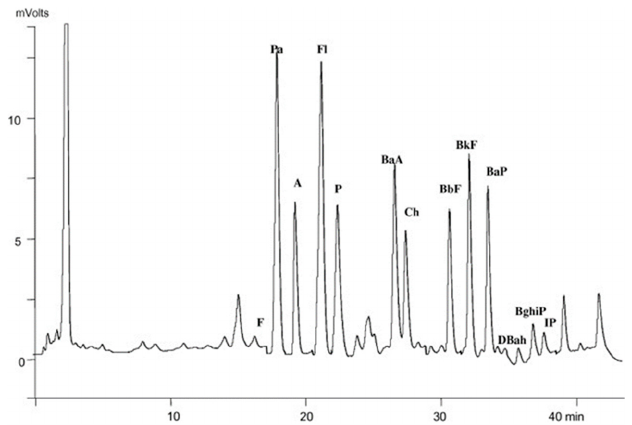
Figure 3. HPLC-FLD (high performance liquid chromatography-spectrofluorometric detection) trace of a sample of raw propolis analyzed directly after MAS, (F) fluorene, (Pa) phenanthrene, (A) anthracene, (Fl) fluoranthene,